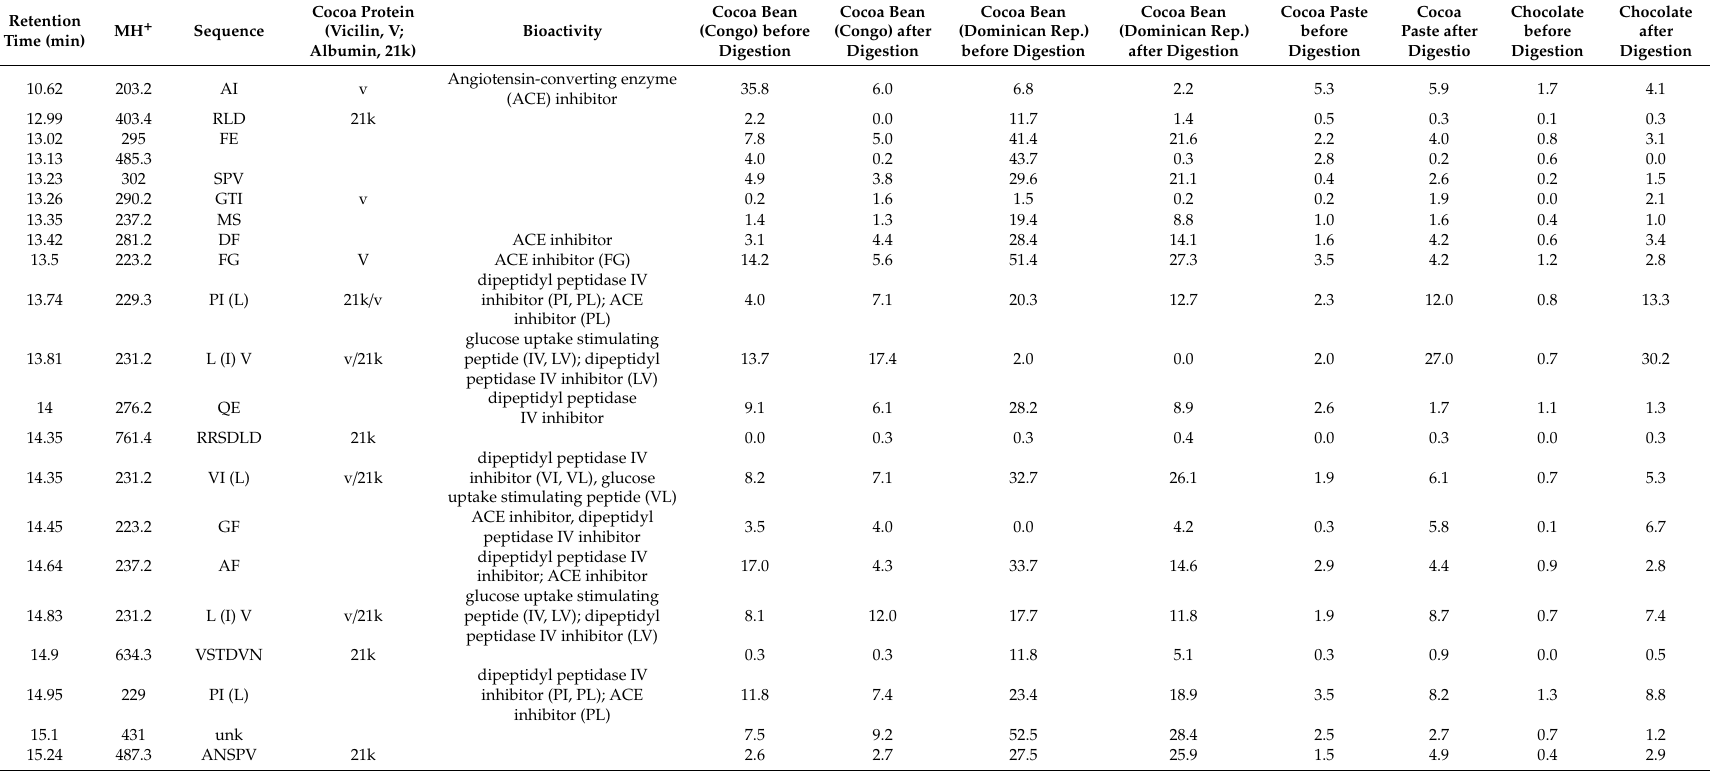
Table 1. Peptides identified in cocoa and derived products before and after digestion, semi-quantitative amounts (mg / kg cocoa) and reported bioactivity from BIOPEP database. Quantitative amounts are calculated utilizing the ratio of peptide area vs. internal standard area (phe-phe), assuming that all response factors are equal to 1. Retention + Bioactivity Time (min) MH